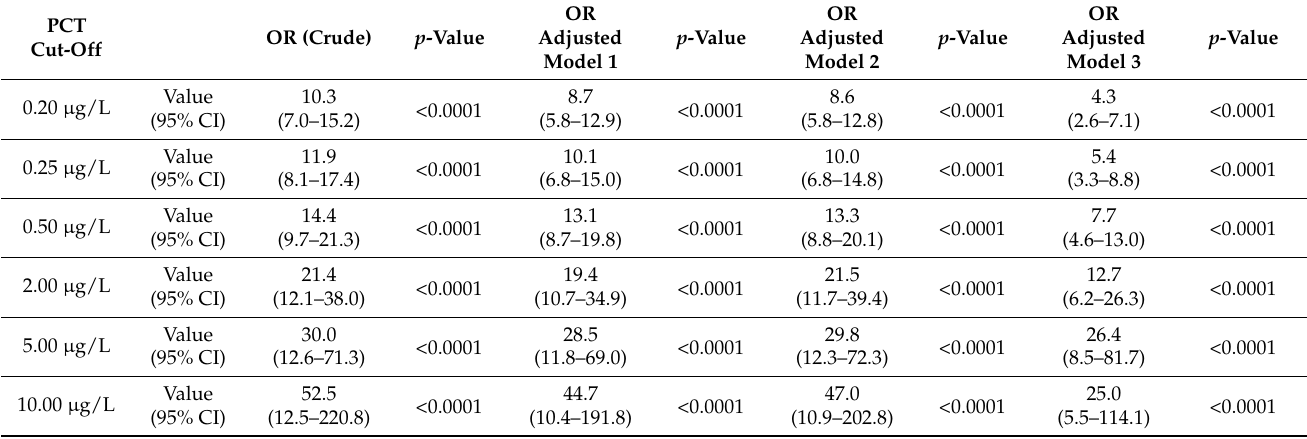
Table 4. Results of the logistic regression analysis of PCT at different cut-off values for the prediction of sepsis in univariate analyses (crude ORs) and adjusted for qSOFA (model 1), adjusted for qSOFA, gender and age (model 2), and adjusted for qSOFA, gender, age, C-reactive protein, lactate, WBC, pre-existing conditions and tumour diseases, IMMUNOSUPRESSION (model 3). One patient was lost to